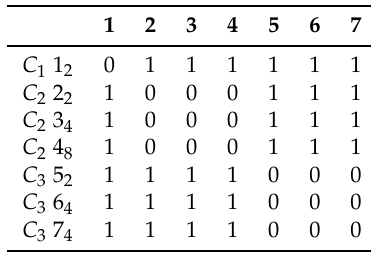
Table 1. Resource matrix. Symmetric matrix with distance between HDCS processors from Figure